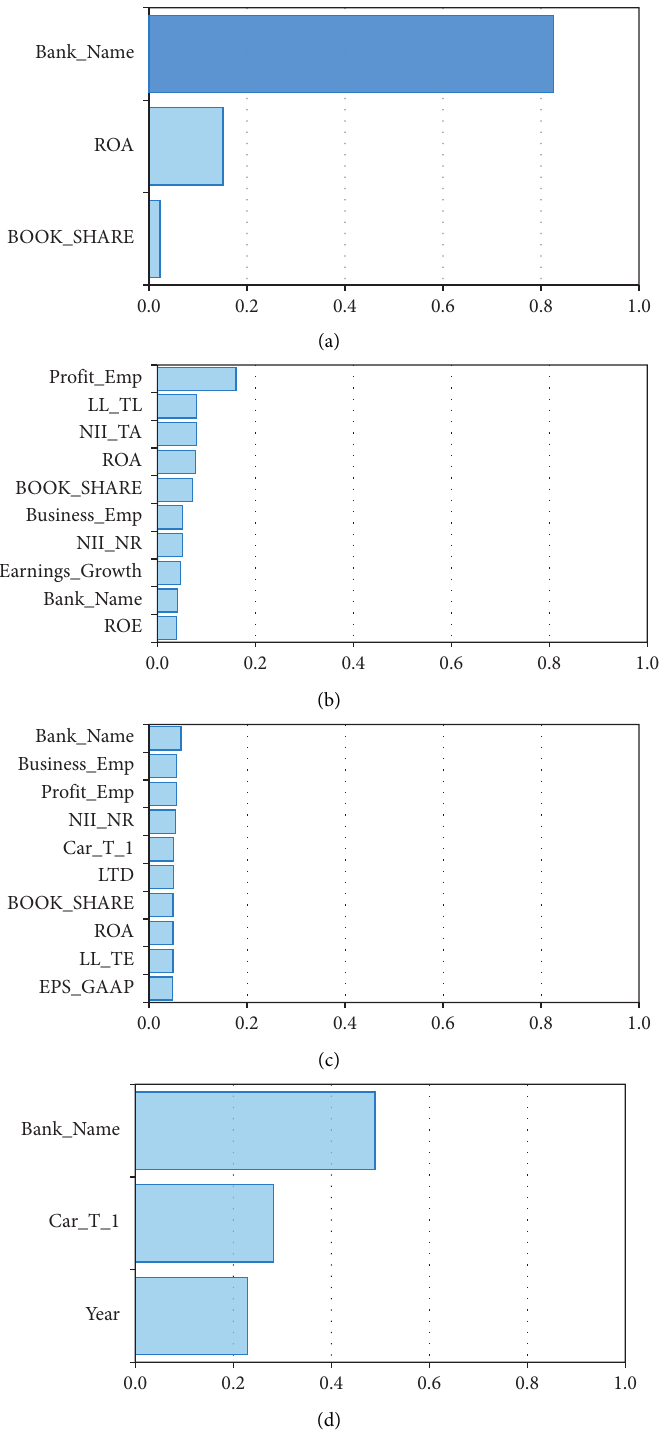
Figure 2: Important predictors by using four prediction models: (a) linear regression, (b) neural network, (c) SVM, and (d) CHAID based on entering all predictors without results of feature selection